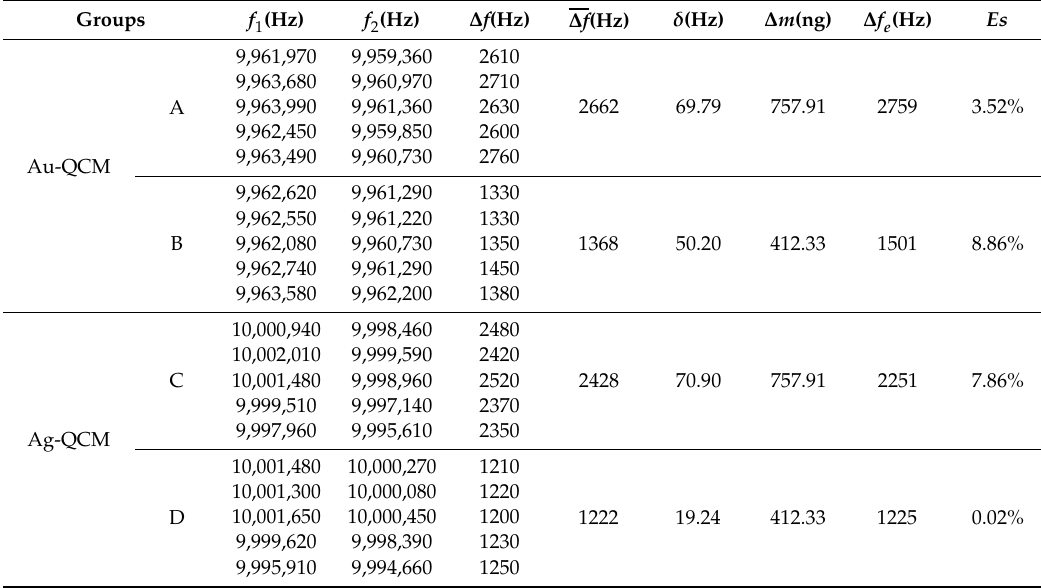
Table 1. Results of the quartz crystal microbalance (QCM) plating